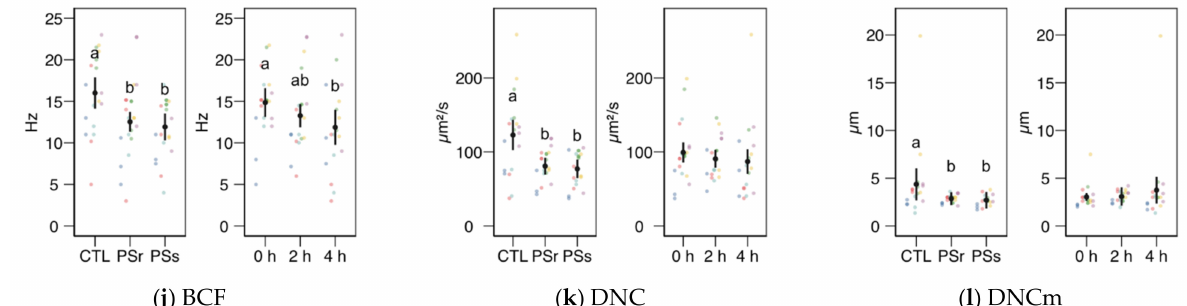
Figure 2. CASA (Computer Assisted Sperm Analysis) variables (mean ± CI95% with individual observations as dots, n = 6) during the incubation (4 h at 37 ◦ C) of thawed boar spermatozoa with seminal plasma from boars whose spermatozoa were resistant or sensitive to the cold-shock (PSr and PSs) or incubated with just MR-A (control, CTL). The interaction treatment × incubation time was not significant, and therefore both factors were analyzed and plotted as main effects (therefore, the plotted observations correspond to the whole experiment, 6 × 3). ( a ) Total motility. ( b ) Progressive motility. ( c ) Curvilinear velocity. ( d ) Average-path velocity. ( e ) Straight-path velocity. ( f ) Linearity. ( g ) Straightness. ( h ) Wobble. ( i ) The amplitude of the lateral displacement of the sperm head. ( j ) Frequency of the flagellar beat. ( k ) Dance. ( l ) Dance mean. Since no interactions were significant, we show the results of the seminal plasma and incubation treatments separately as main effects. Different letters show significant differences among treatments or times ( p < 0.05).